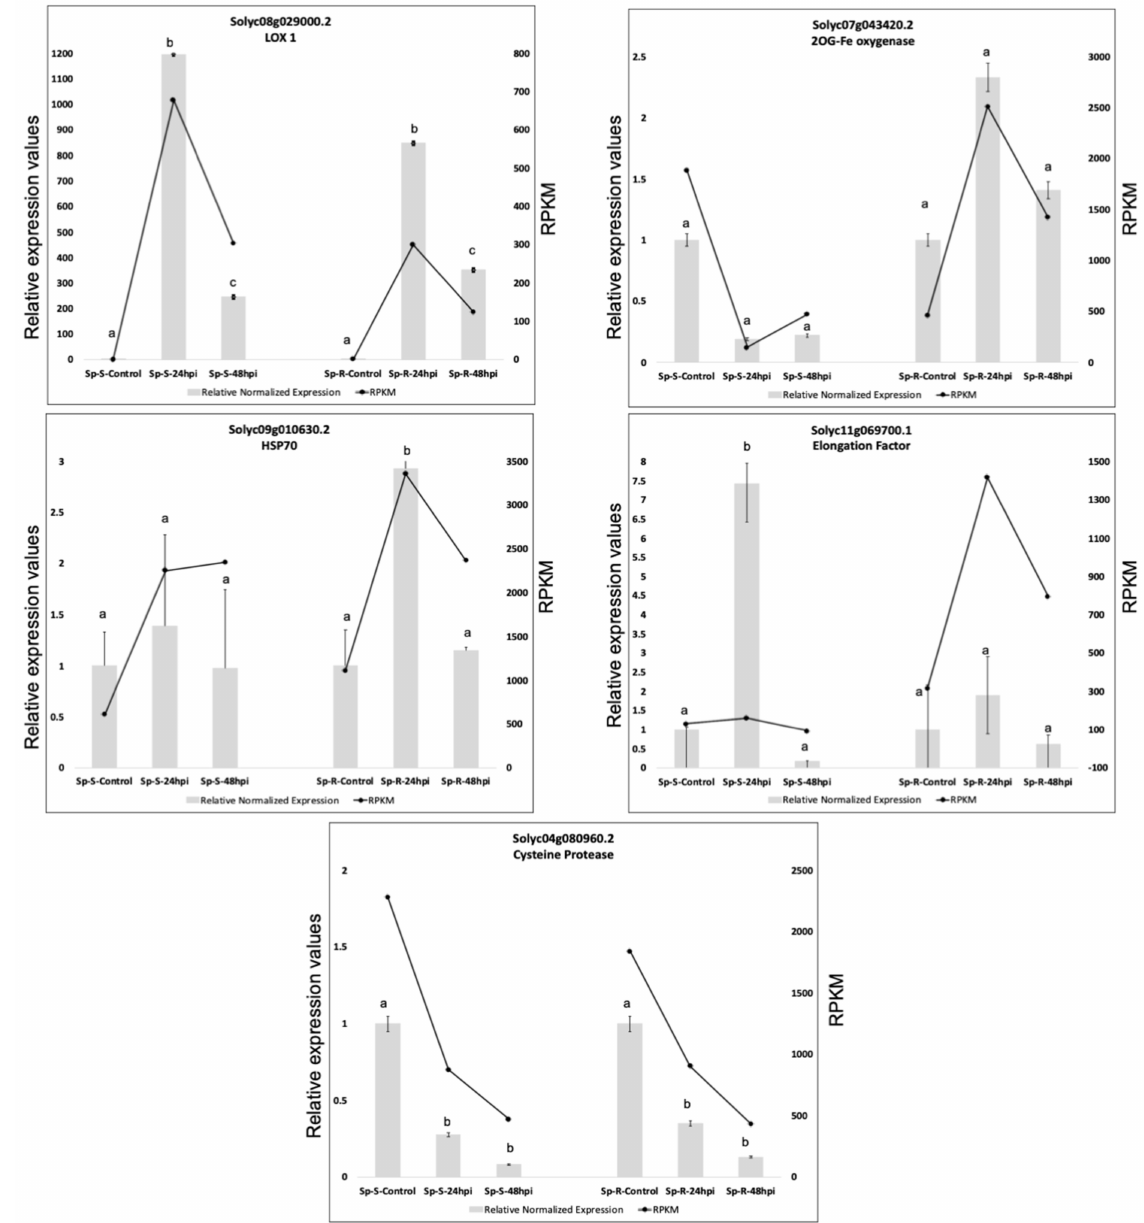
Figure 11. qRT-PCR based validation of plant defense related DEGs of wild tomato in response to P. parasitica . Expression levels of tested genes were normalized based on transcript levels of Actin gene. RPKM values calculated from RNA-seq are compared to relative expression values determined by qRT-PCR analysis. Relative expression values of infected samples were determined by using the average expression value of all replicates of a particular group. Standard deviation among replicates is represented by error bars. Different alphabets represent significant difference at p -value <